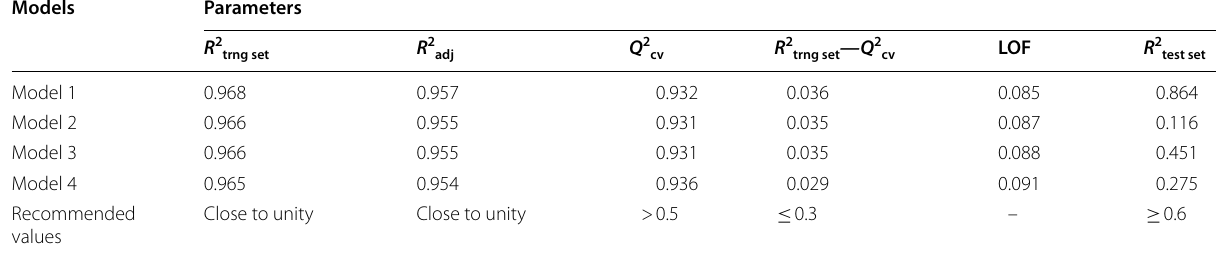
Table 2 Validation parameters of the models generated with the recommended values for assessing a valid QSAR model Models